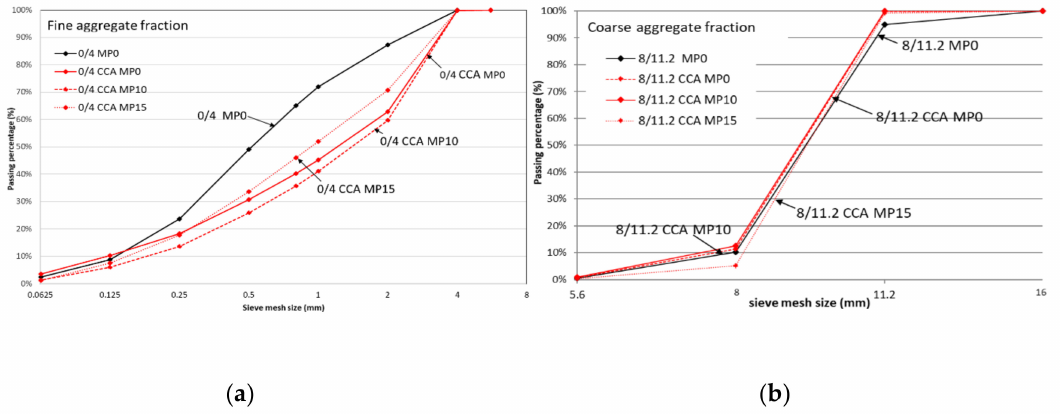
Figure 3. Grading curves with mechanical pre-processing ( a ) fine fraction ( b ) coarse fraction.